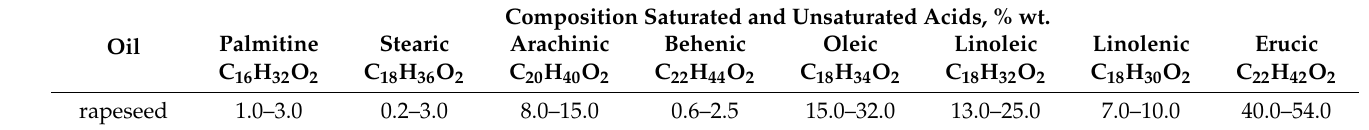
Table 2. Composition of rapeseed oil. Composition Saturated and Unsaturated Acids, % wt.